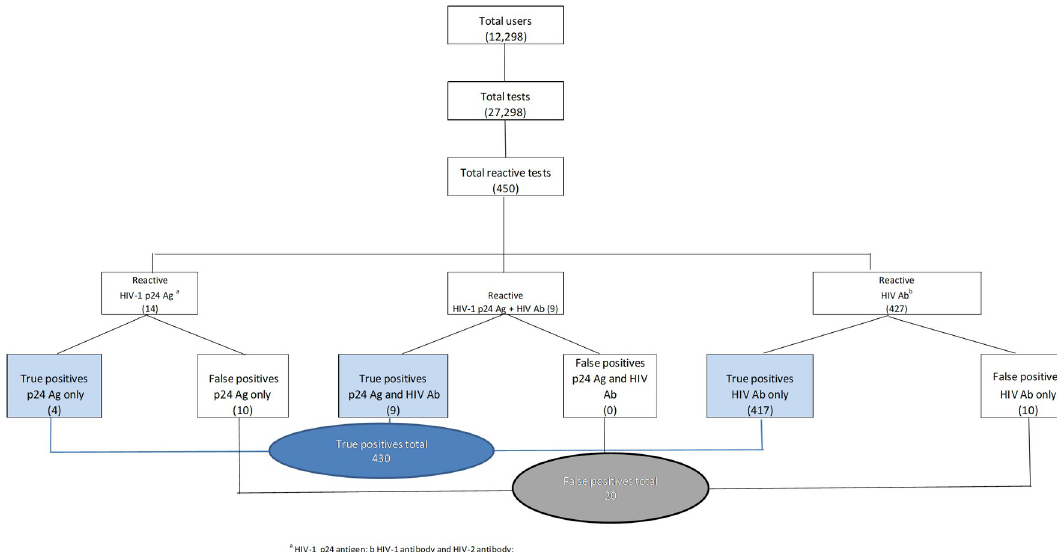
Fig 1. Flowchart showing the results of p24 Ag and HIV Ab tests performed at BCN checkpoint.